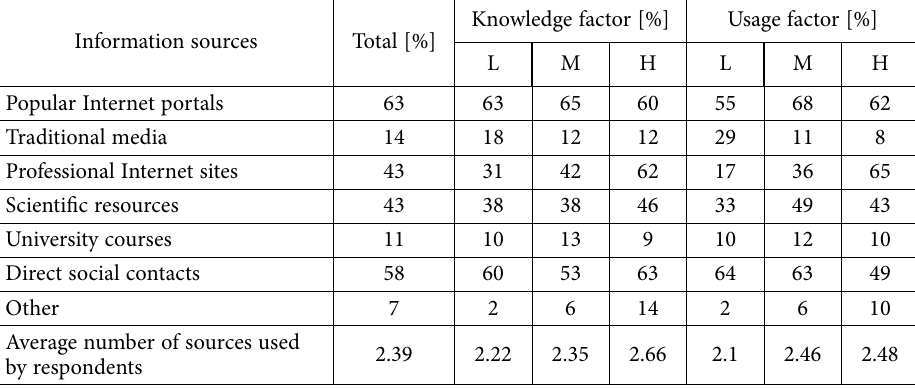
Table 4. Information sources’ distribution in relation to knowledge and usage factors